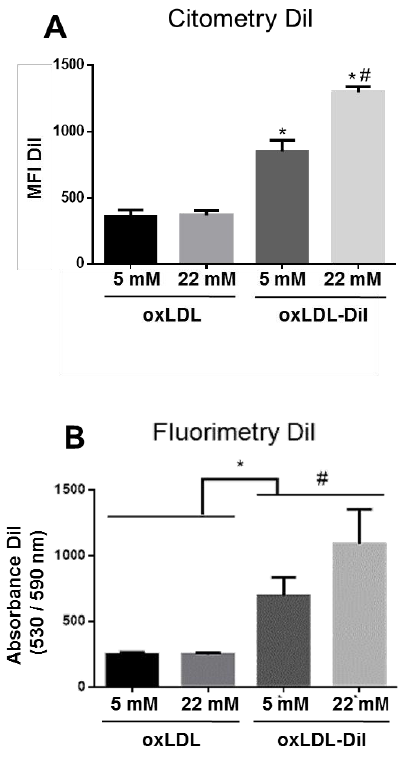
Figure 2. High glucose triggers oxLDL uptake by VSMC. oxLDL uptake was analyzed by flow cytometry ( A ) and by fluorimetry ( B ) in VSMC incubated for 72 h with NG or HG (22 mM) and treated with 1,1′-dioctadecyl-3,3,3′,3-tetramethylindocarbocyanine perchlorate oxLDL (DiI-oxLDL) (5 µg / mL) for the last 24 h. Cells incubated with unlabeled oxLDL were taken as control in flow cytometry and fluorimetry assays. Mean fold change relative to VSMC-NG ± SEM from four independent experiments performed in duplicate are shown. * p ≤ 0.05 vs. non-labeled oxLDL; # p ≤ 0.05 vs. 5 mM + DiI-oxLDL or 22 mM. MFI: Median fluorescence intensity.